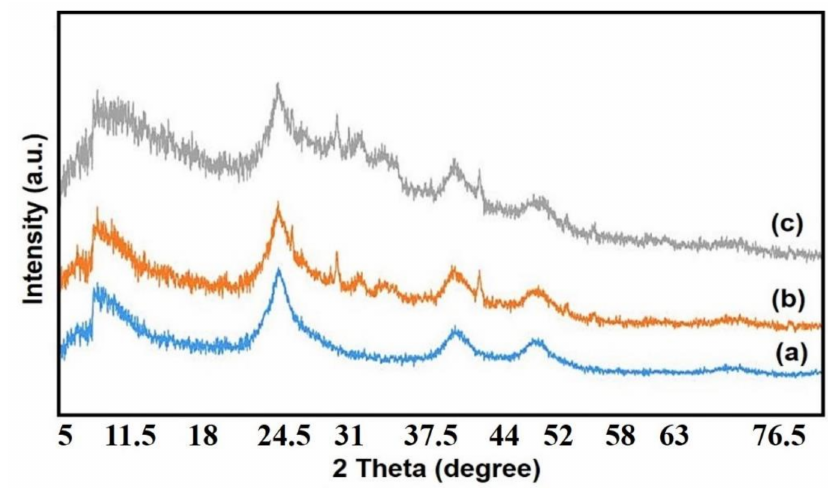
Figure 2. X-ray di ff raction (XRD) patterns of ( a ) CdS, ( b ) Pt-Ag 3 PO 4 / CdS / chitosan, and ( c ) CdS / Ag 3 PO 4 .